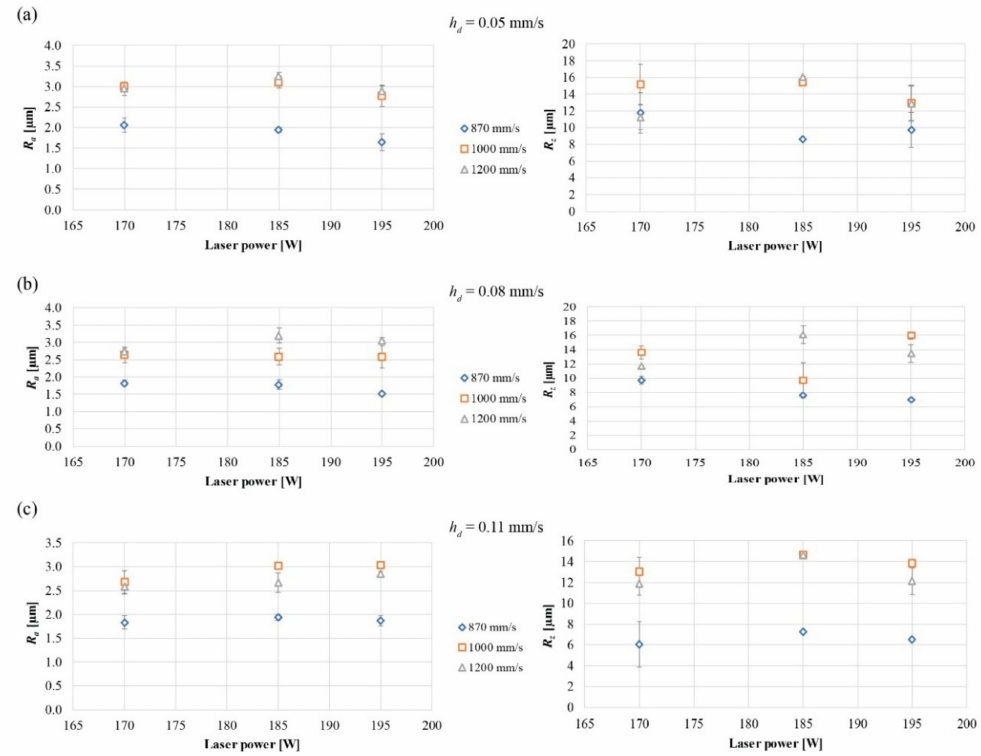
Figure 6. Values of surface roughness R a ( left ) and R z ( right ) measured in the top areas for di ff erent values of scan speed and laser power with respect to hatching distance of ( a ) 0.05 mm / s, ( b ) 0.08 mm / s, and ( c ) 0.11 mm /